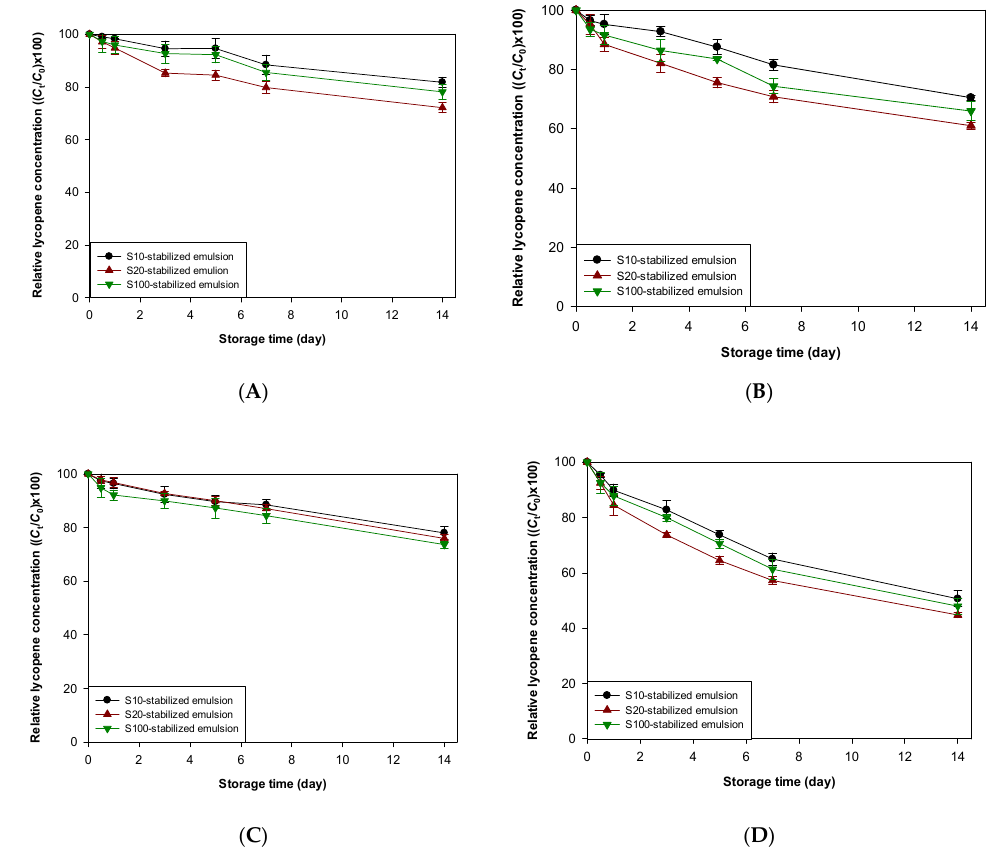
Figure 3. Effect of TBHQ ( A , B ) and lauryl gallate ( C , D ) on the stability of lycopene concentrations over storage in emulsions stored at 25 °C at pH 7 ( A , C ) and 3 ( B , D ). C 0 , initial lycopene concentration in emulsion; C t , lycopene concentration in emulsion at t day of storage.